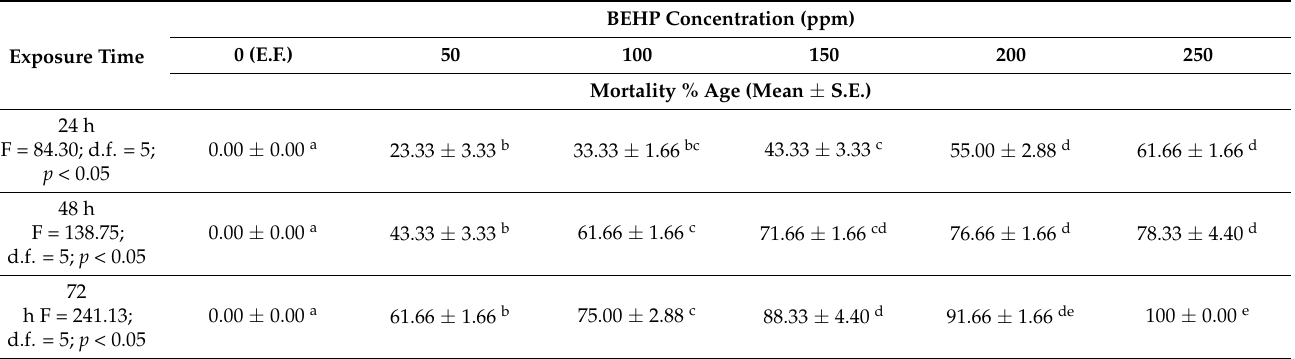
Table 2. Mortality (%age) of 4th instar C. quinquefasciatus larvae at different time intervals and concentrations of BEHP.